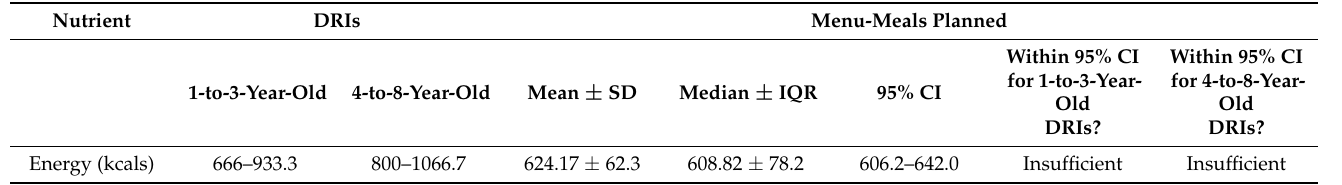
DRIs, dietary reference intakes representing two-thirds of the daily recommended intake value. Kcals, kilocalories. SD, standard deviation. IQR, interquartile range. CI, confidence interval.